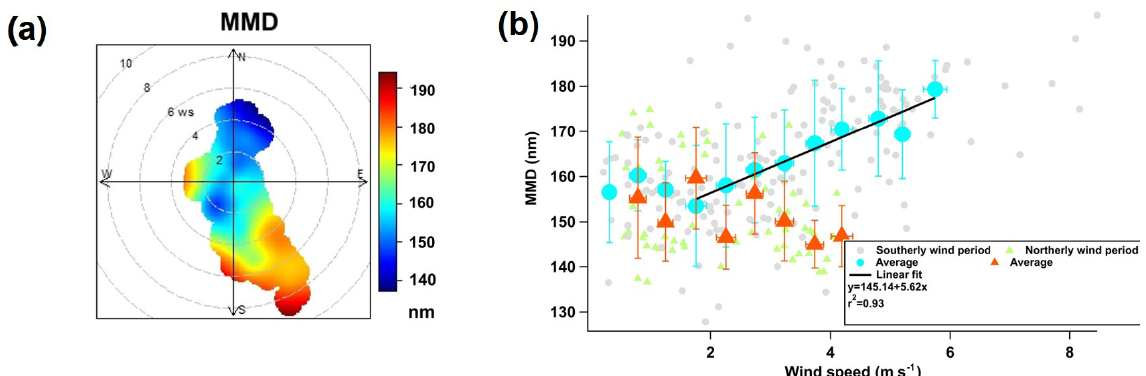
Figure 6. (a) Dependence of rBC’s MMD on wind speed and wind direction during the observation period. (b) MMD versus wind speed during the southerly wind period and northerly wind period. The error bars correspond to the standard deviations of MMD in each wind speed